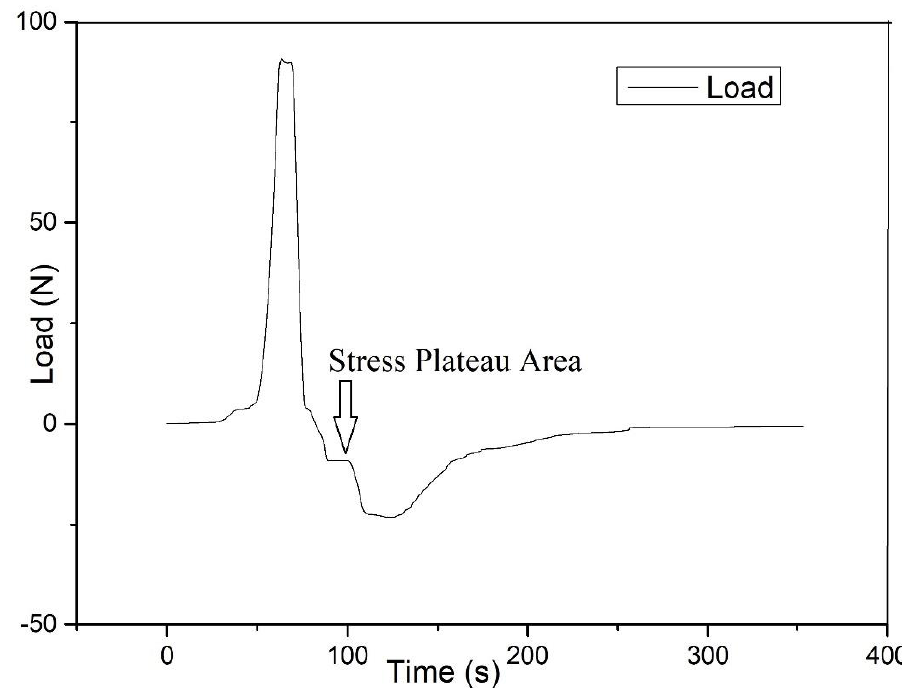
Figure 15. Stress plateau area.